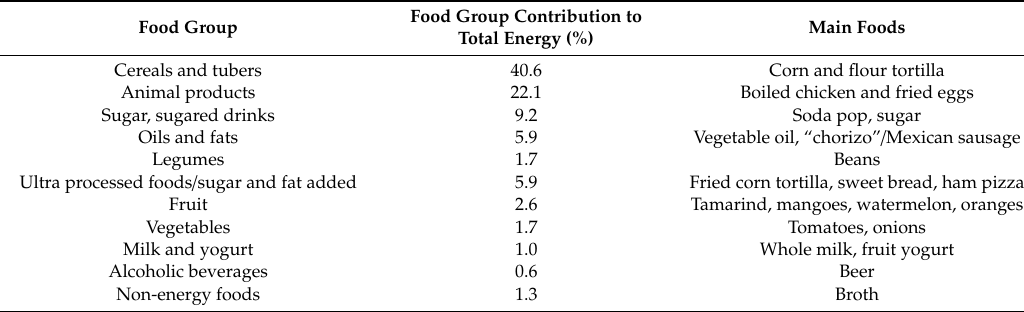
Table 2. Main energy-supplying foods per food